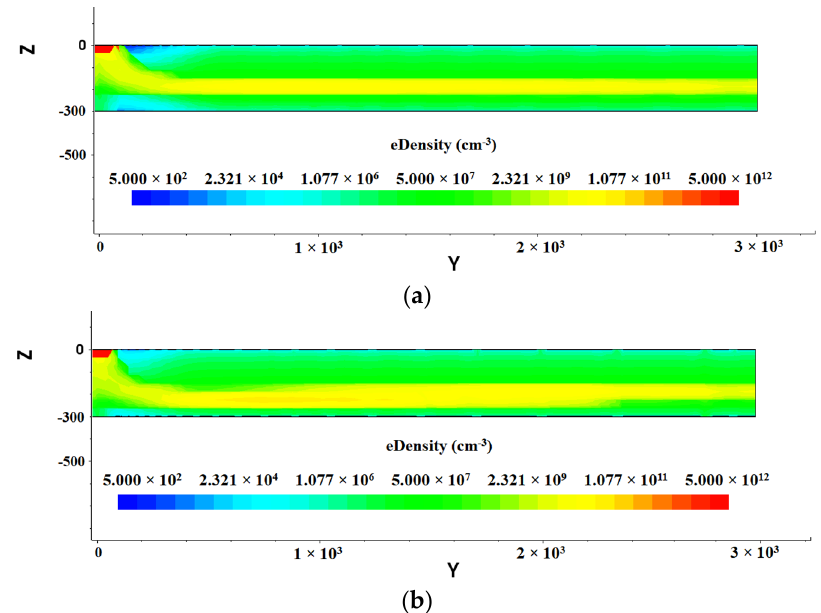
Figure 9. Distribution of electron concentration inside SDD: ( a ) gap 10 µm; ( b ) gap 25 µm.